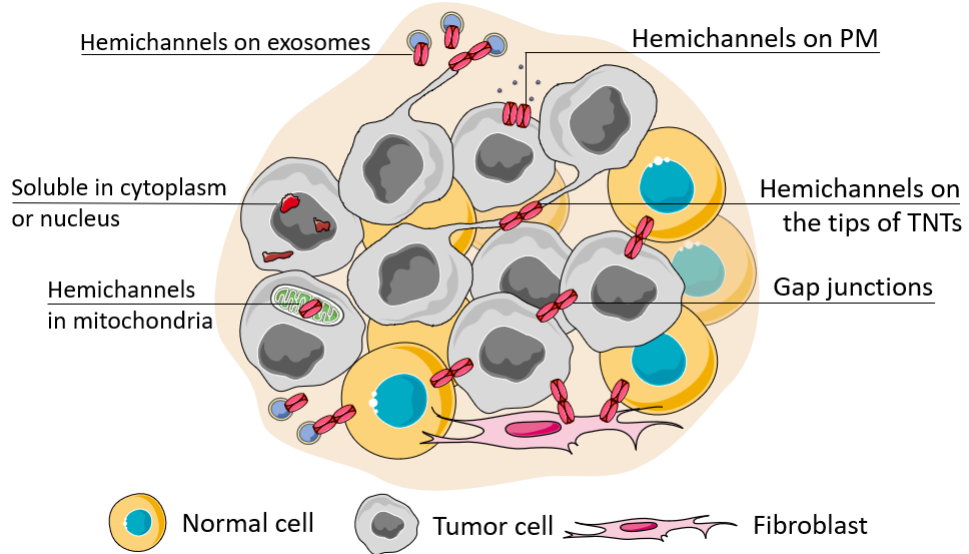
Figure 2. Possible localization of connexins in the cell. The localization of connexins in the cell can be attributed to its soluble forms (located in the nucleus or cytoplasm) or membrane-bound forms which can be observed during its trafficking, ultimately represented as a functional connexin residing in the cell membrane in the hemichannel or channel state (when docked with a connexin of a neighboring cell). The localization of connexin channels at the membrane can be considered relatively to their localization to the basal membrane (cell polarity), attributed to cell protrusions (e.g., tunneling nanotubes, TNTs) or extracellular vesicles (e.g., exosomes). Connexins can be also transferred to the inner membrane of mitochondria.